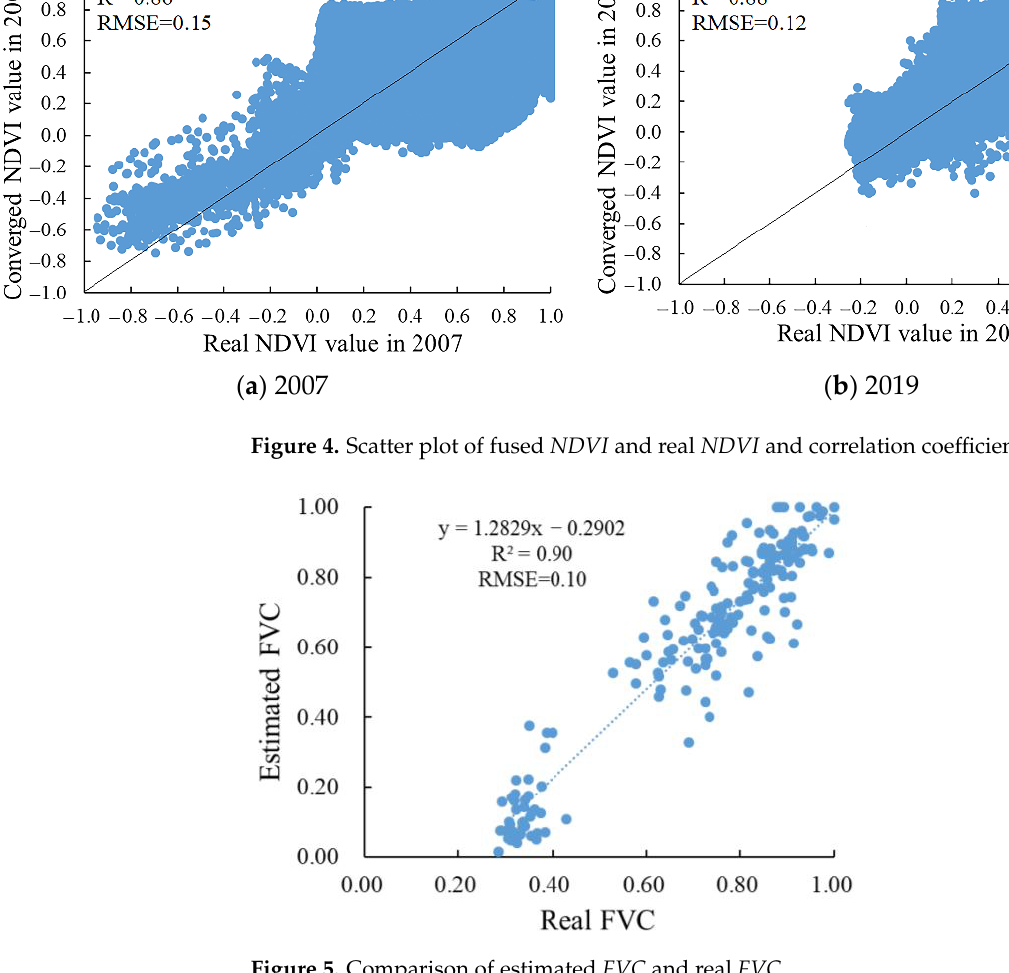
Figure 5. Comparison of estimated FVC and real FVC.